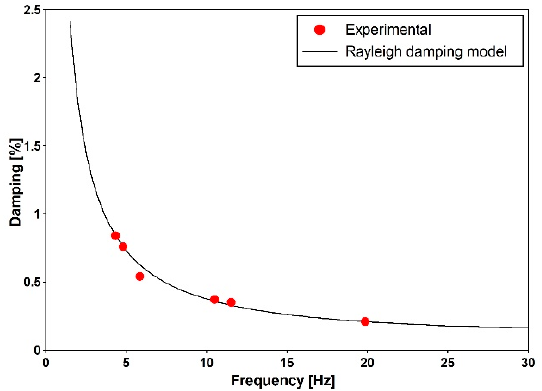
Figure 16. The dependence of the damping ratio on the frequency for the determined Rayleigh coefficients along with the damping ratios detected experimentally for particular mode shapes.